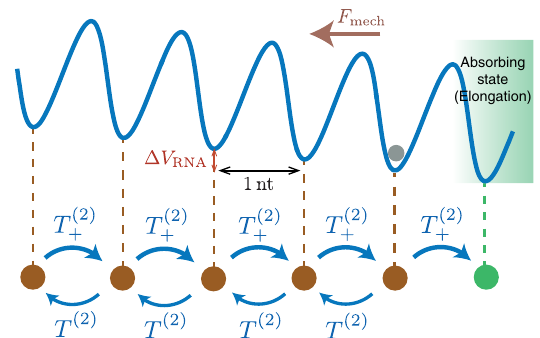
FIG. 13. The dynamics of RNA polymerase during back- tracking. The motion of the polymerase is represented as a diffusion process in a tilted periodic potential with an absorbing boundary on the right (which corresponds to the transition from the backtracked state into the elongating state). The period of the potential is equal to the length of one nucleotide (nt). The potential is tilted towards the absorbing boundary due to an energetic barrier Δ V , and an external opposing mechanical RNA force F pushes the polymerase away from the absorbing mech boundary. This process can be coarse grained into a discrete one- 2 Þ dimensional hopping process with waiting times T ð and T ð 2 Þ − þ